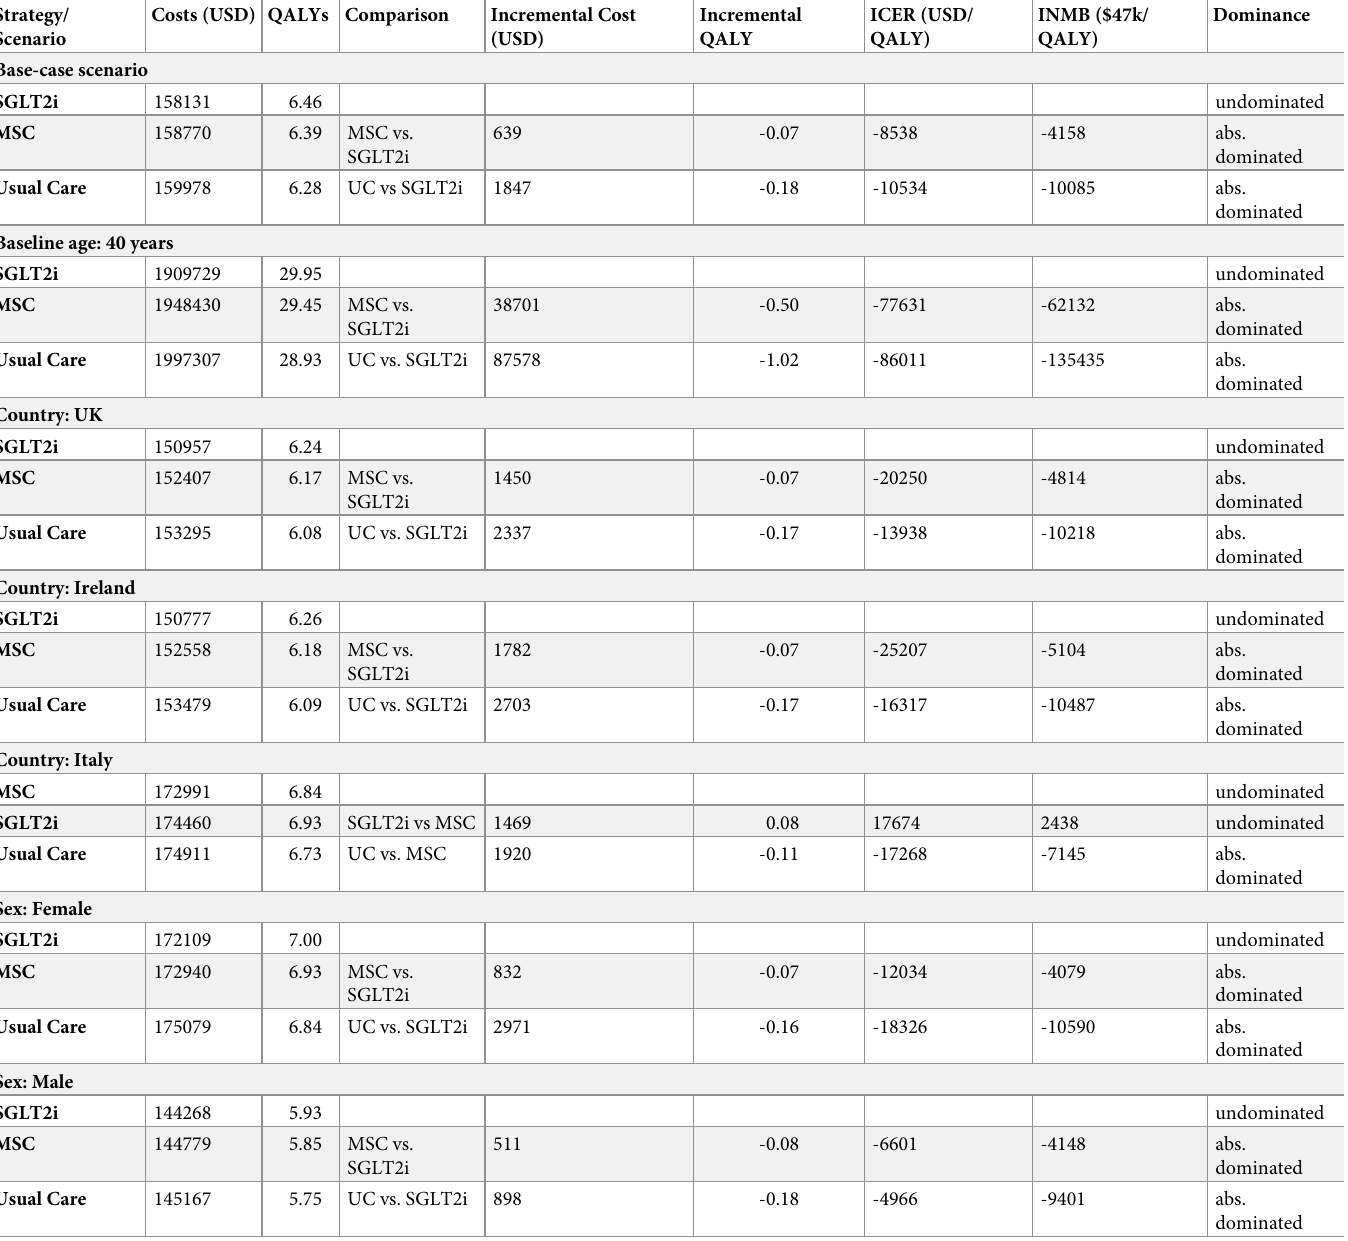
Table 1. Cost-effectiveness analysis results across scenarios. Strategy/